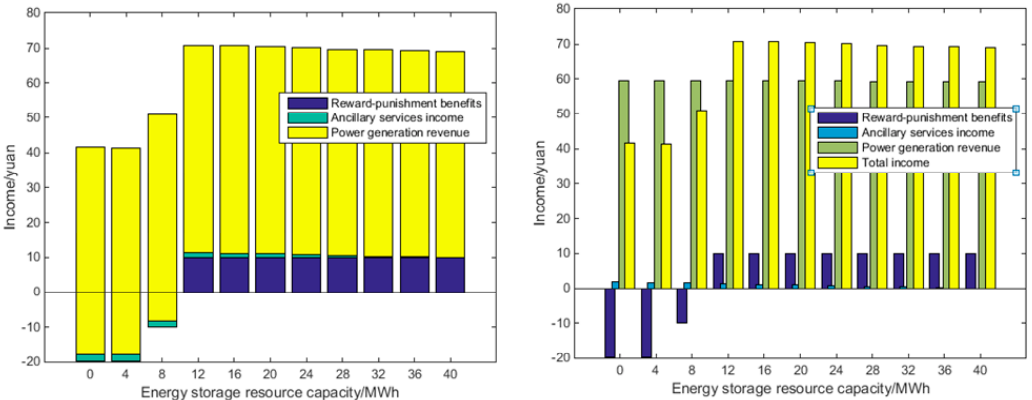
Figure 12. The revenue of VPP of typical scenario 12.